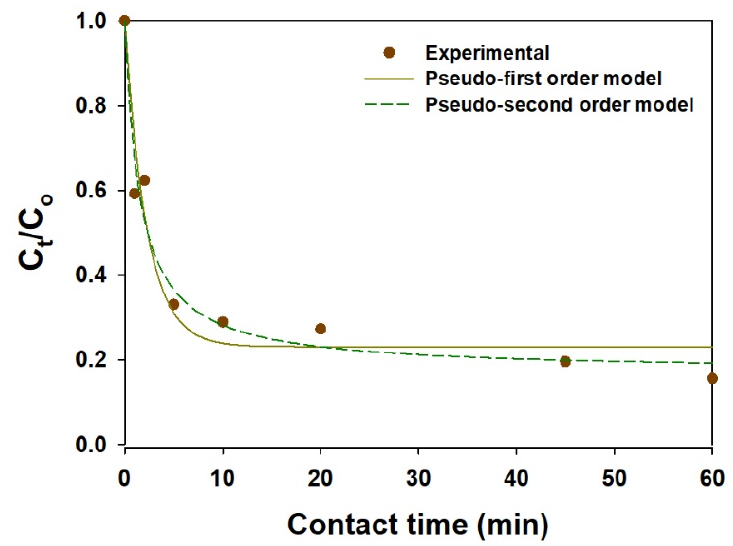
Figure 12. Kinetic adsorption of I − on the mag@silica-Ag composite. Adsorbent 0.01 g, I − solution 10